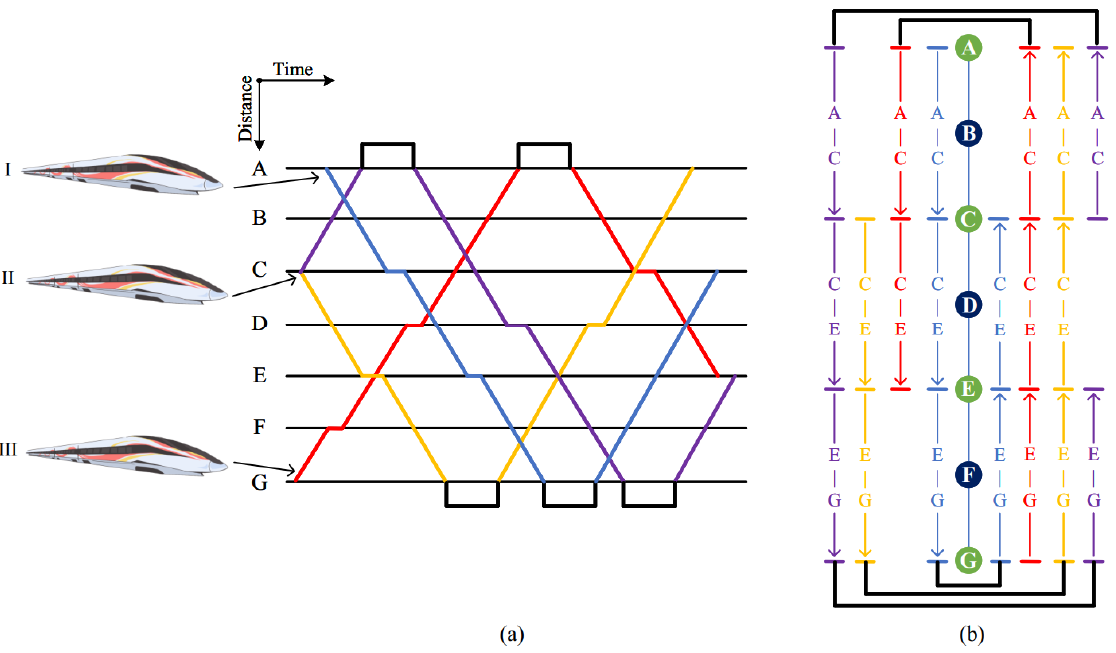
Figure 7. The train-set directions sequence. ( a ) The train-set directions schematic diagram in timetable; ( b ) The schematic diagram of train-set directions sequence’s format.